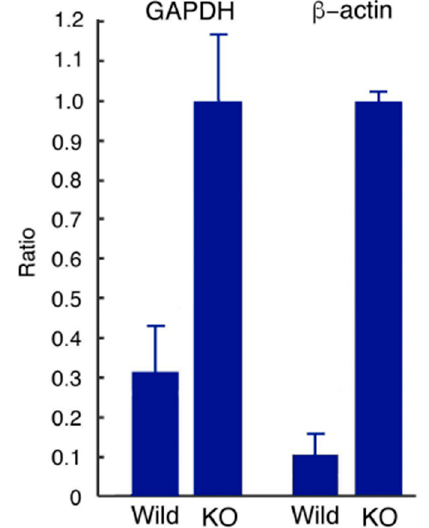
Figure 3. Real-time quantitative PCR analysis for TST mRNA. When GAPDH was used as an internal control gene, mRNA expression of TST in KO mice was approximately 3.3 times greater than expression in wild-type mice ( p = 4.43 × 10 − 3 , n = 3). On the other hand, when β -actin was used as the internal control gene, the ratio was approximately 9.1 ( p = 6.69 × 10 − 3 , n = 3).